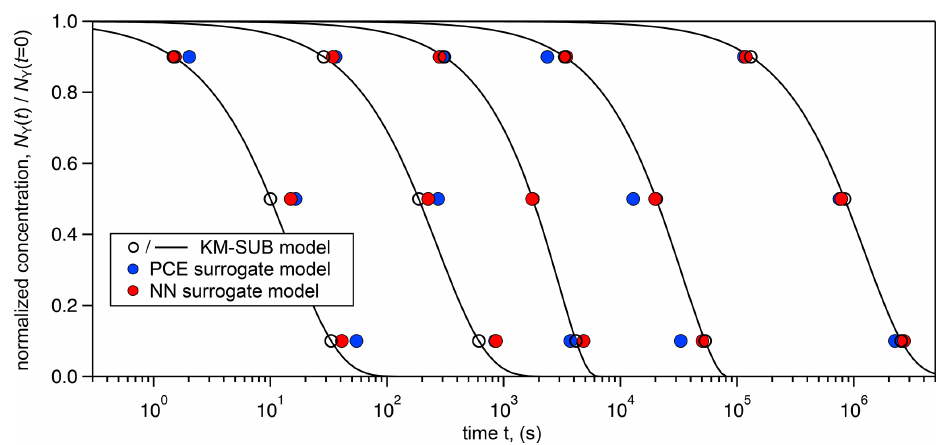
Figure 3. Comparison of time-dependent output of the surrogate models (PCE method – blue markers; NN method – red markers) with KM- SUB model output (solid black lines) for five arbitrarily chosen KM-SUB runs spanning seconds to weeks of reaction time. The surrogate models’ predicted time for depletion of 10%, 50%, and 90% of reactant Y in the aerosol phase. KM-SUB output at these three stages is highlighted with open black markers.